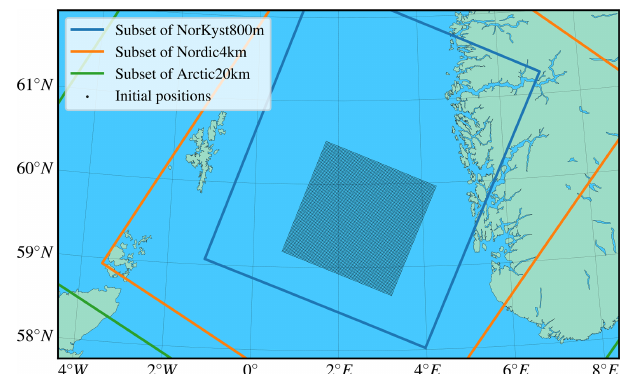
Figure 3. Map showing the outline of the three datasets considered, as well as the initial positions of the tracers used in the numerical